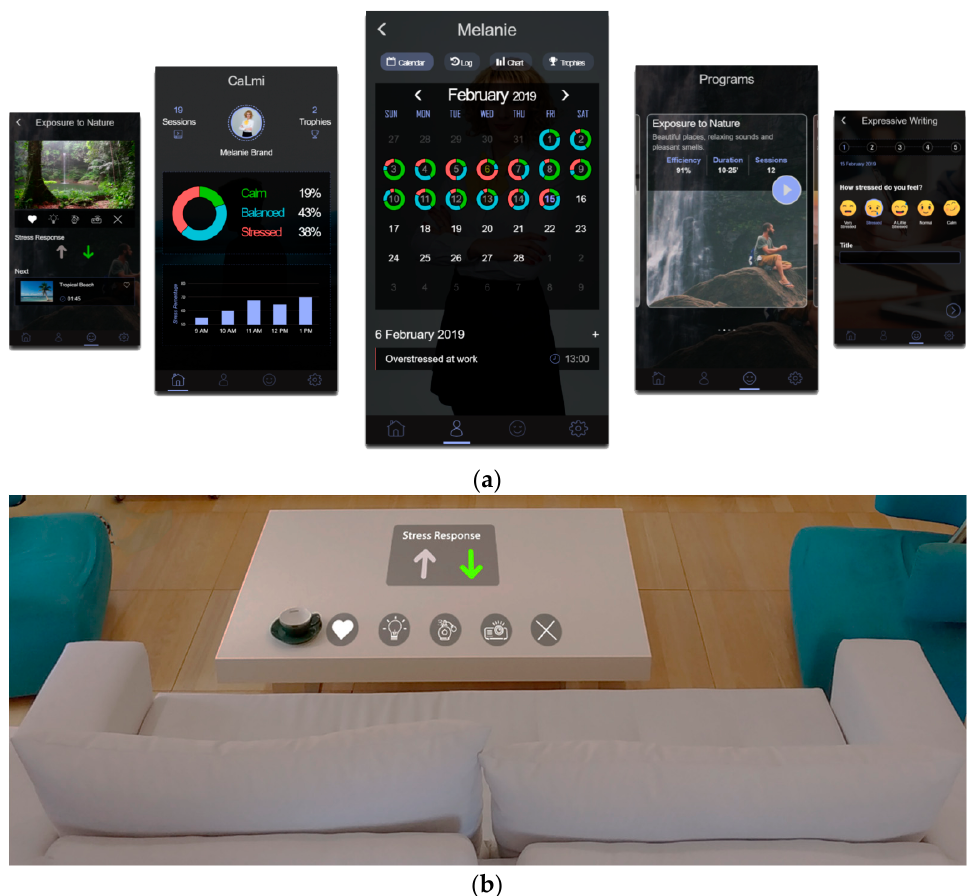
Figure 5. ( a ) User Interface of CaLmi’s mobile application; ( b ) Real time stress response and ses- sion’s control menu on the coffee table. control menu on the coffee